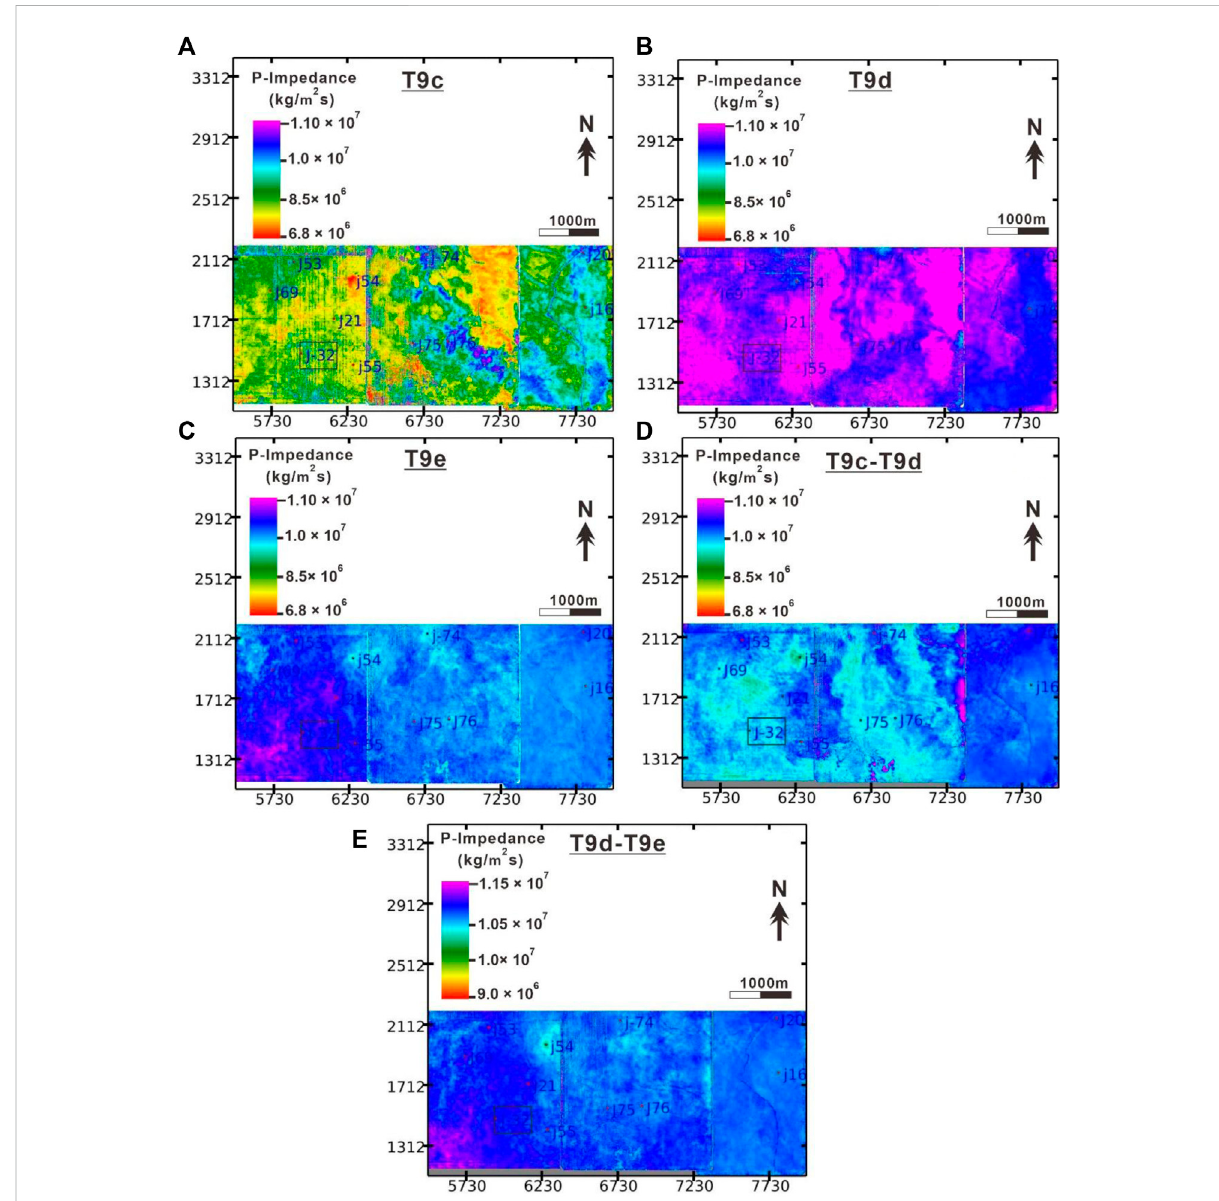
FIGURE 8 Impedancemapsof (A) T9c, (B) T9d, (C) T9e, (D) T9c-T9d,and (E) T9d-T9ehorizons.ThestudiedwellJ32asacasestudyishighlightedbyblack color